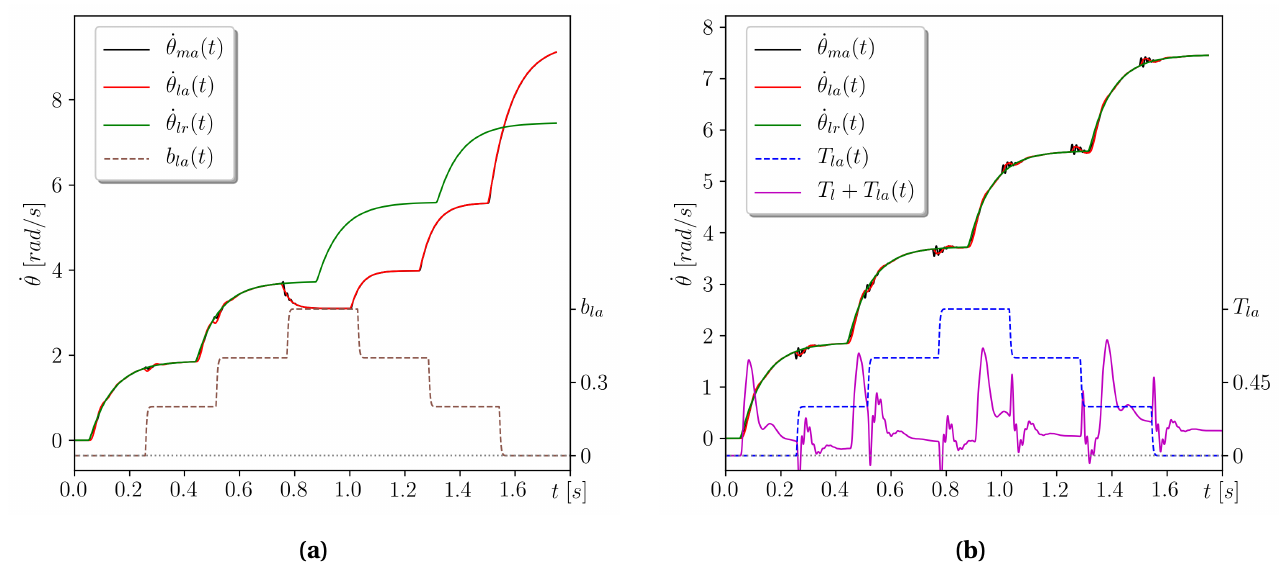
Figure 6. The closed-loop reference model control system response at the presence of: ( a ) b la ( t ) ; ( b ) T la ( t ) disturbance and a PID regulator (low frequency)—see case A in the block diagram in Figure 3.